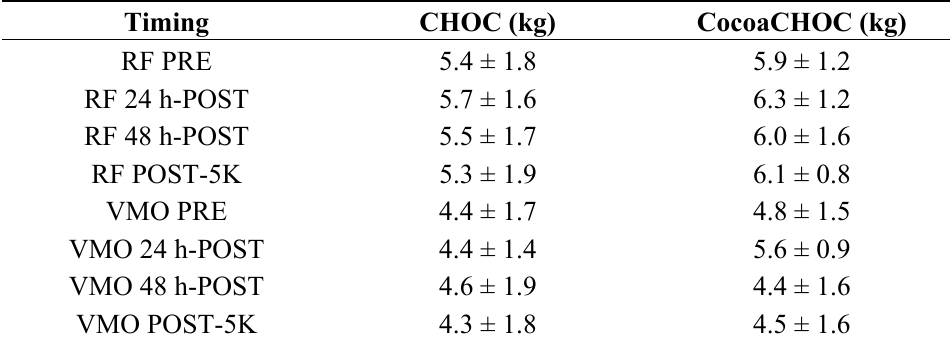
Table 4. Mean muscle tenderness scores of the rectus femoris (RF) and vastus medialis oblique (VMO) between treatment beverages over time ( n =